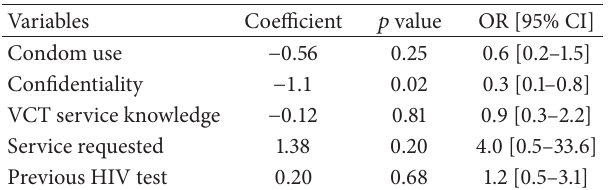
Table5:HIVtestingresultfromVCTversusattitudeandbehavioral